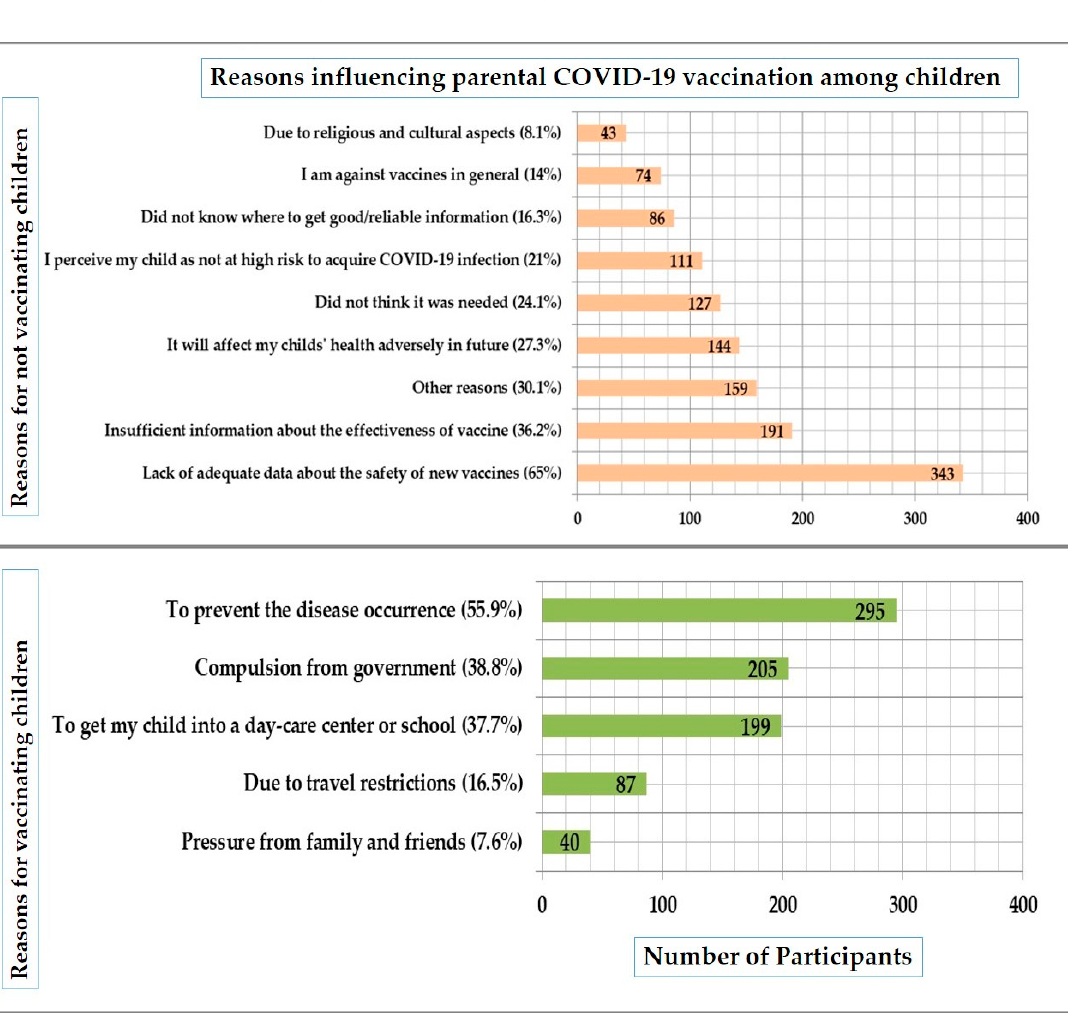
Figure 3. Reasons influencing parents’ decision to vaccinate their children against